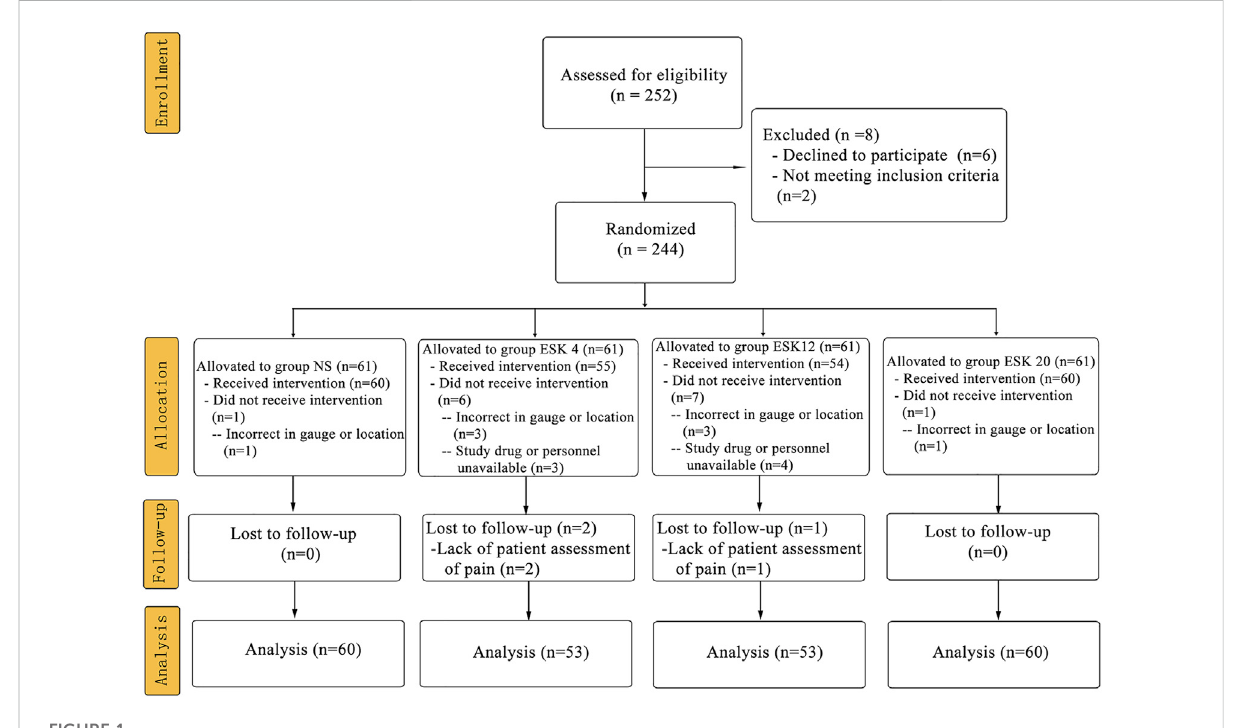
FIGURE 1 CONSORT fl ow of clinical procedures. Abbreviations: NS: normal saline; ESK: esketamine.